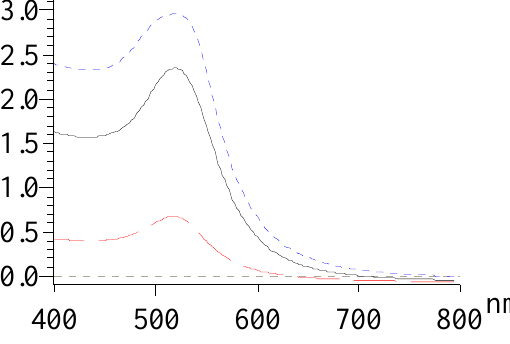
Figure 2. UV spectra of 13-nm AuNPs. a) 3.5 nM, direct reduction; b) 17 nM, direct reduction; c) 17 nM, centrifuging (from bottom to top).